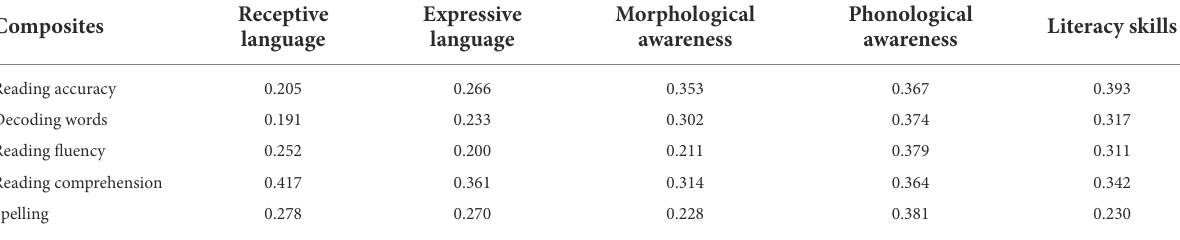
TABLE 5 Correlations between composite scores (Time 2) and later reading and spelling.